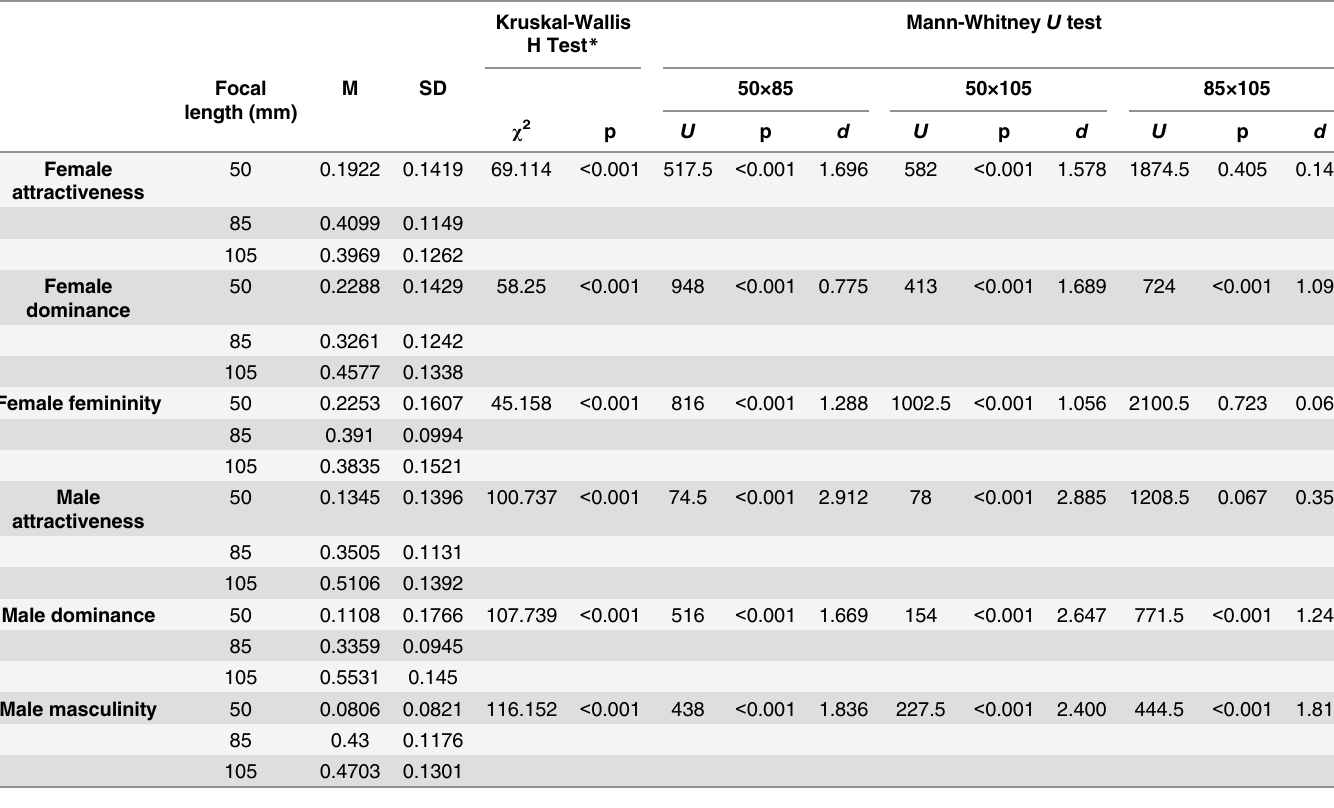
Table 2. The differences in mean proportion of first choices for attractiveness, dominance and femininity/masculinity between focal lengths.